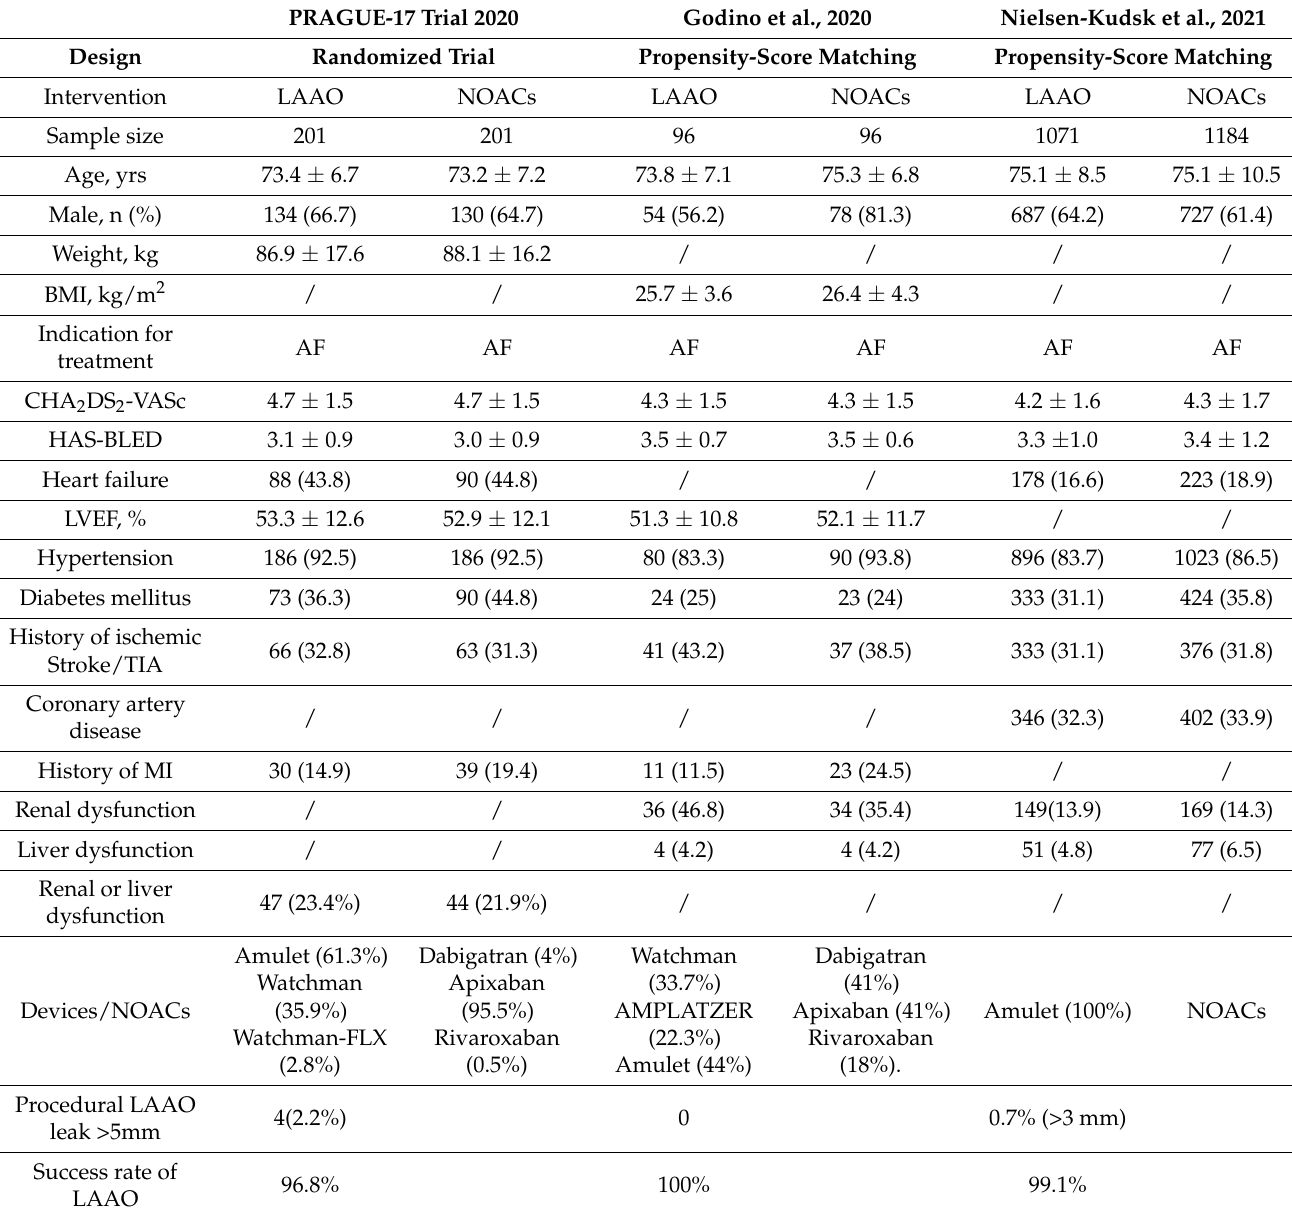
Table 1. Baseline characteristics in included